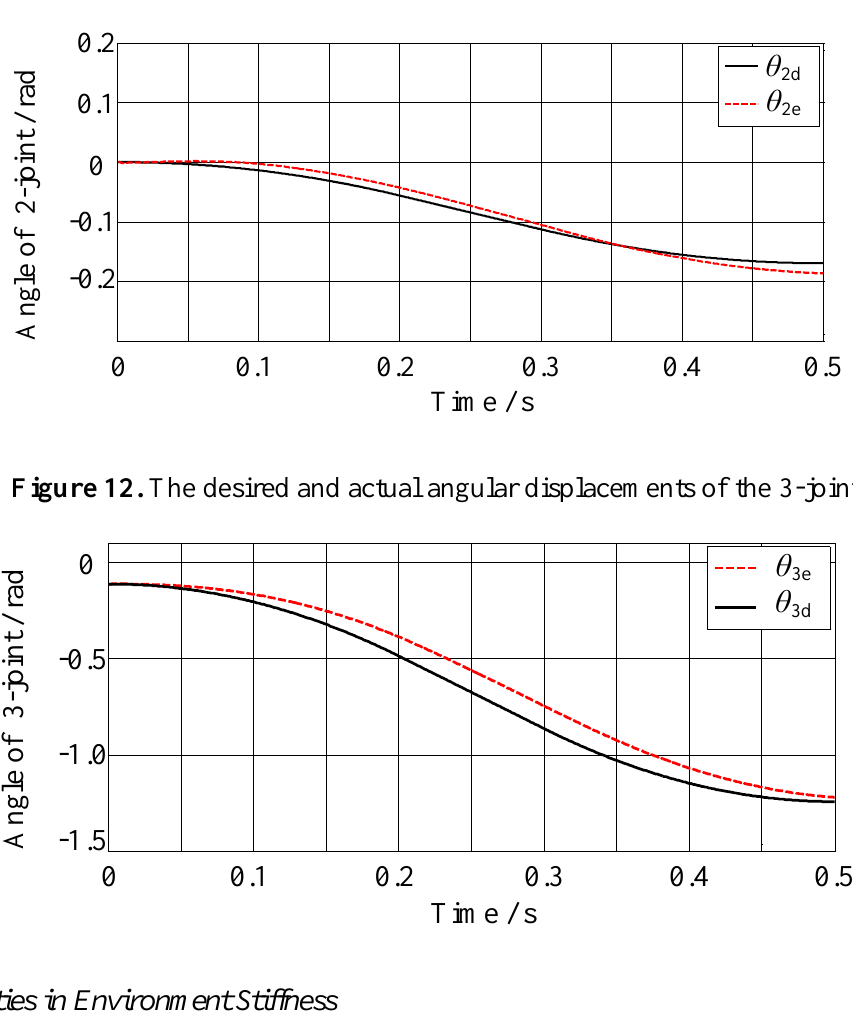
Figure 11. The desired and actual angular displacements of the 2-joint.